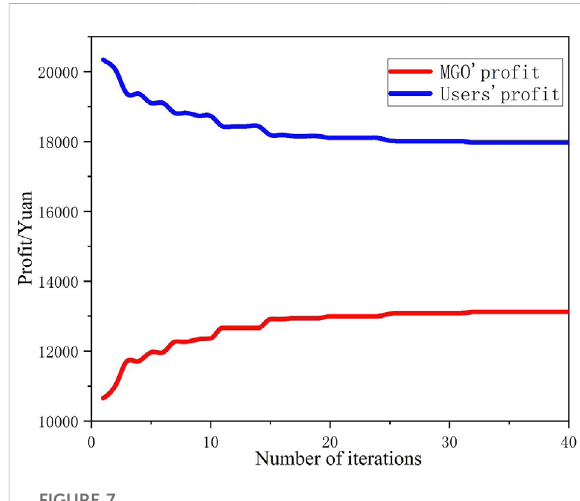
FIGURE 7 Case 3: convergence process of the Stackelberg equilibrium.